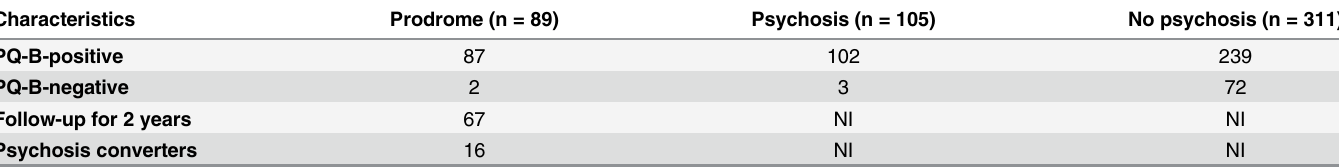
Table 1. Characteristics of subjects included in the present